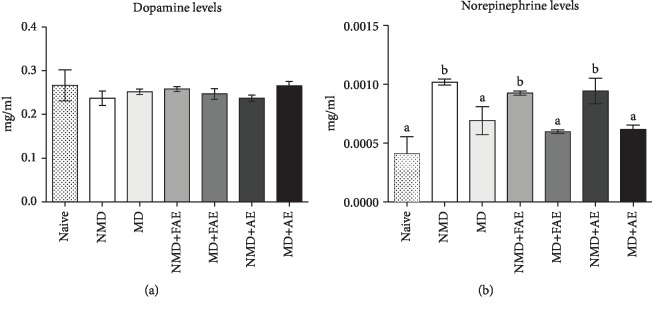
Hippocampal dopamine and norepinephrine levels on nonmaternal-deprived and maternal-deprived rats. Rats were trained in the OR task; some of them were submitted to an aerobic exercise shot, and after, hippocampus was removed. Bars depict HPLC dopamine (a) and norepinephrine (b) levels in hippocampal homogenates (mean ± SD). All bars with letter “A” are statistically equal and differ significantly to all bars with letter “B.” P ≤ 0.05 on ANOVA followed by Tukey's multiple comparison test; n = 3‐5 per group, analyzed in triplicate. OR = object recognition test; NMD = nonmaternal-deprived rats; MD = maternal-deprived rats; NMD+FAE = nonmaternal-deprived rats submitted to aerobic exercise familiarization; MD+FAE = maternal-deprived rats submitted to aerobic exercise familiarization; NMD+AE = nonmaternal-deprived rats submitted to aerobic exercise familiarization and to an aerobic exercise session; MD+AE = maternal-deprived rats submitted to aerobic exercise familiarization and to an aerobic exercise session.